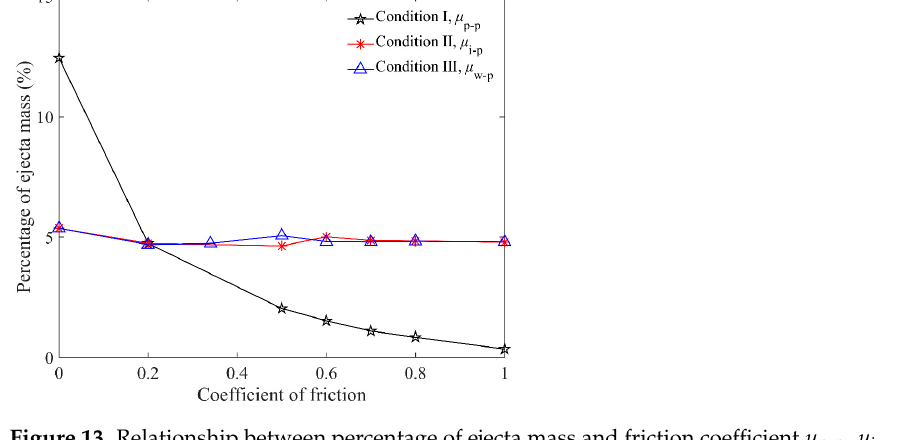
Figure 13. Relationship between percentage of ejecta mass and friction coefficient μ p-p , μ i-p , and μ w-p for L p = 6 mm elongated particles. Condition Ⅰ : μ i-p = 0.2, μ w-p = 0.34 and various μ p-p s; condition Ⅱ : μ p-p = 0.2, μ w-p = 0.34 and various μ i-p s; condition Ⅲ : μ p-p = 0.2, μ i-p = 0.2 and various μ w-p s.